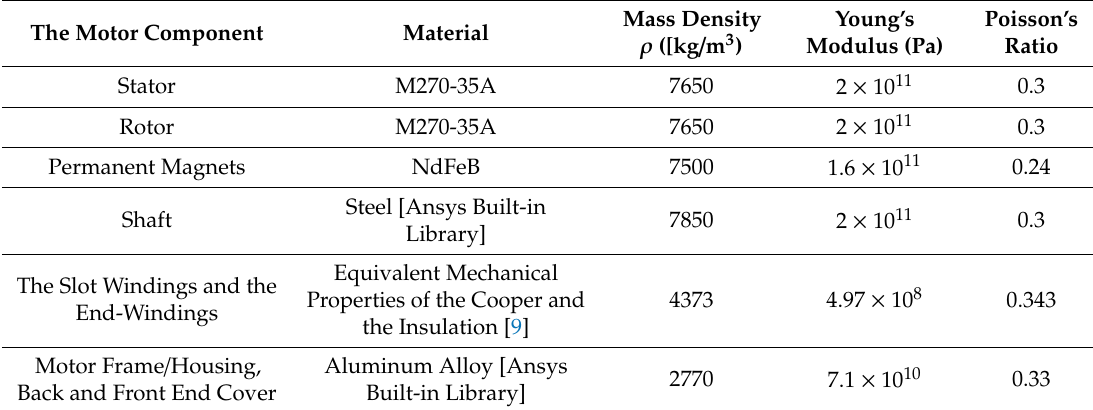
Table 2. The mechanical material properties of the IPM